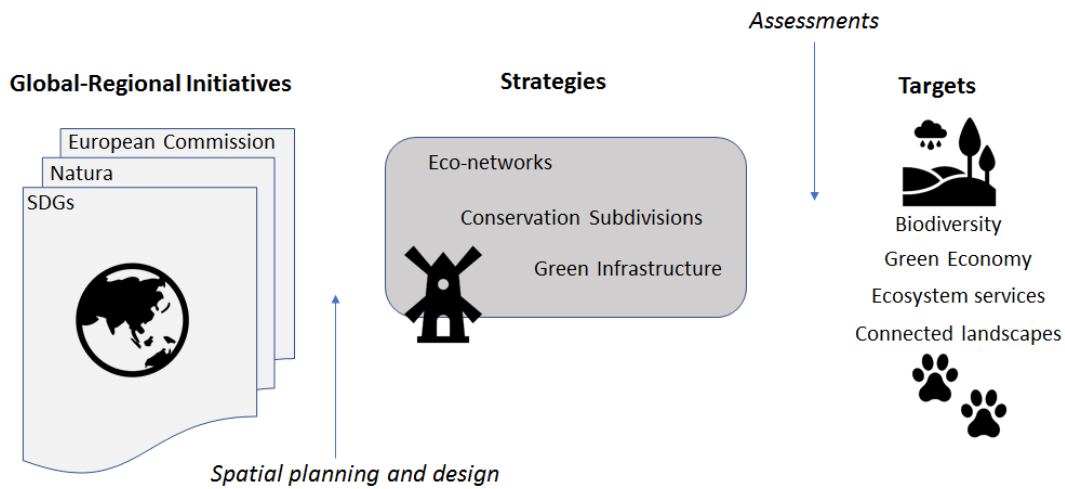
Figure 3. Conceptual relationship between broad scale international initiatives to achieve goals in human–environment targets (e.g. connected landscapes) through various landscape-based strategies. Spatial planning and design produce plans for these strategies, including green infrastructure, while various assessments, including connectivity models, inform and evaluate the strategies in meeting targets. SDGs = global sustainable development goals.